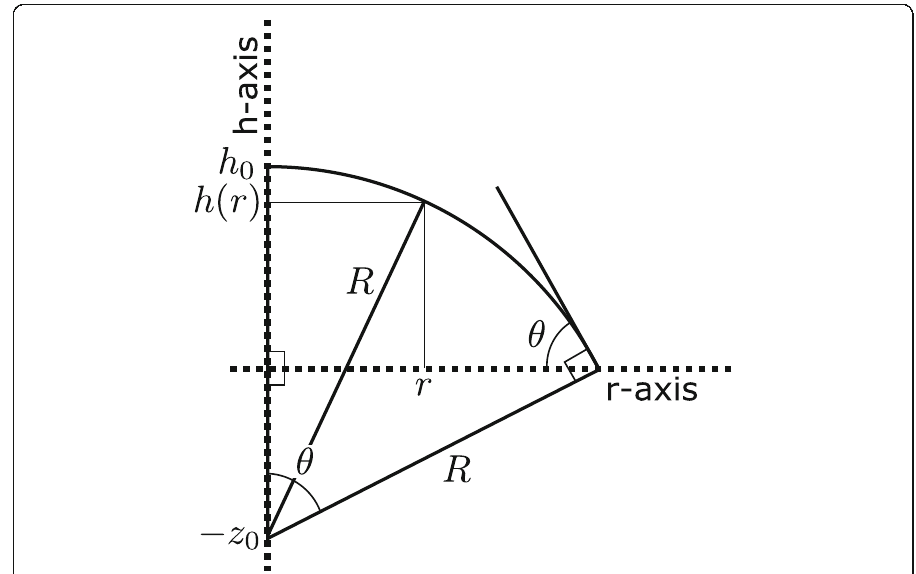
Fig. 8 Geometry for calculating the contact angle from two points on the